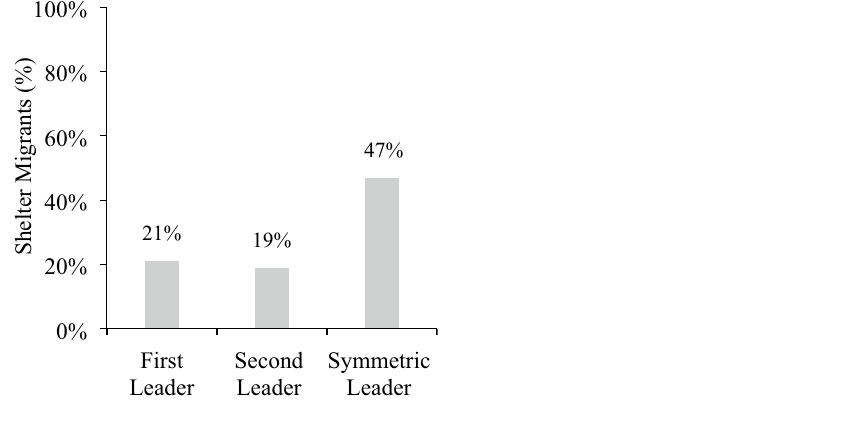
Figure 3. Participants’ decisions to shelter by